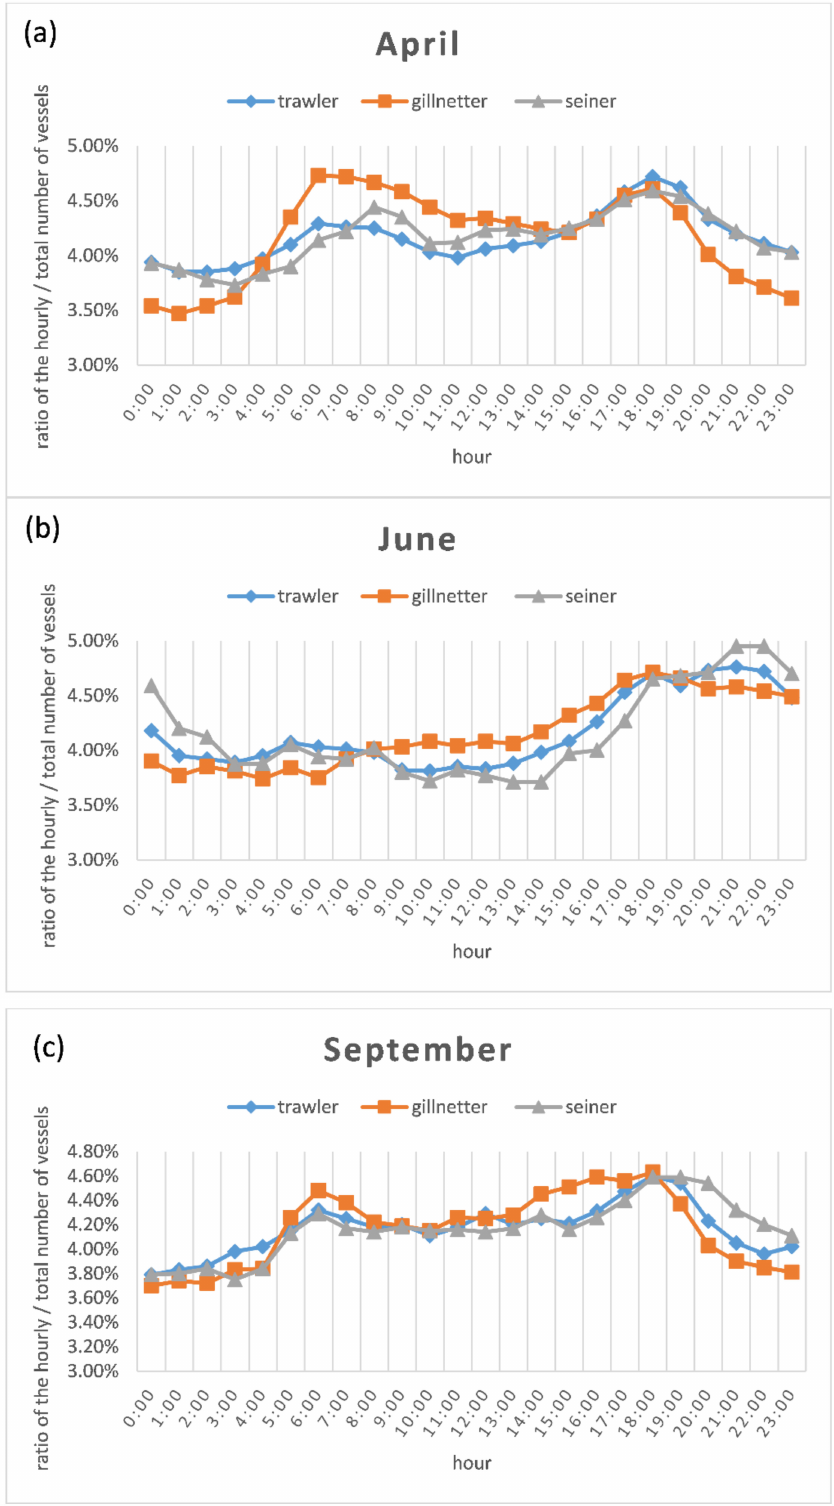
Figure 17. Statistics for Chinese fishing vessels per hour in April ( a ), June ( b ) and September ( c